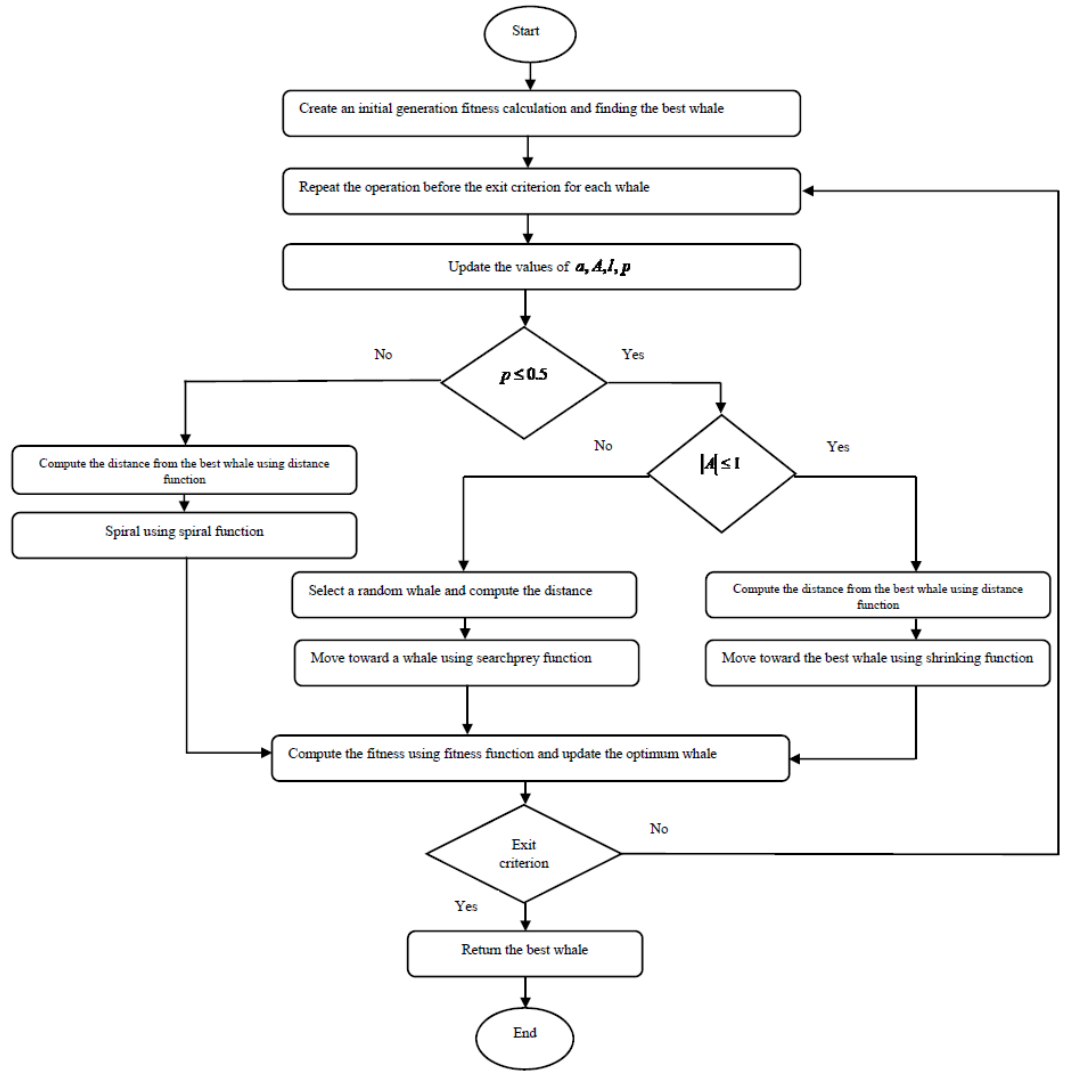
Figure 2. Flowchart of the proposed algorithm.